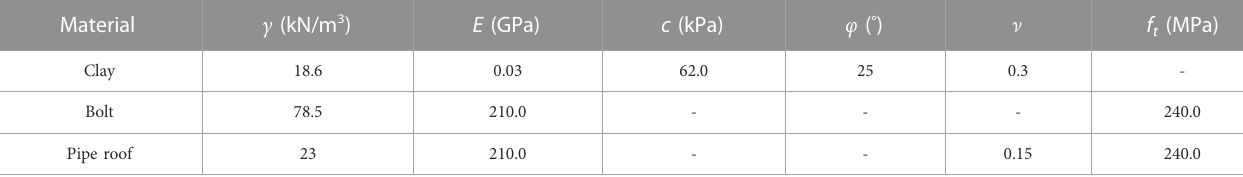
TABLE 2 Physico-mechanical parameters of surrounding rocks and initial support. Material